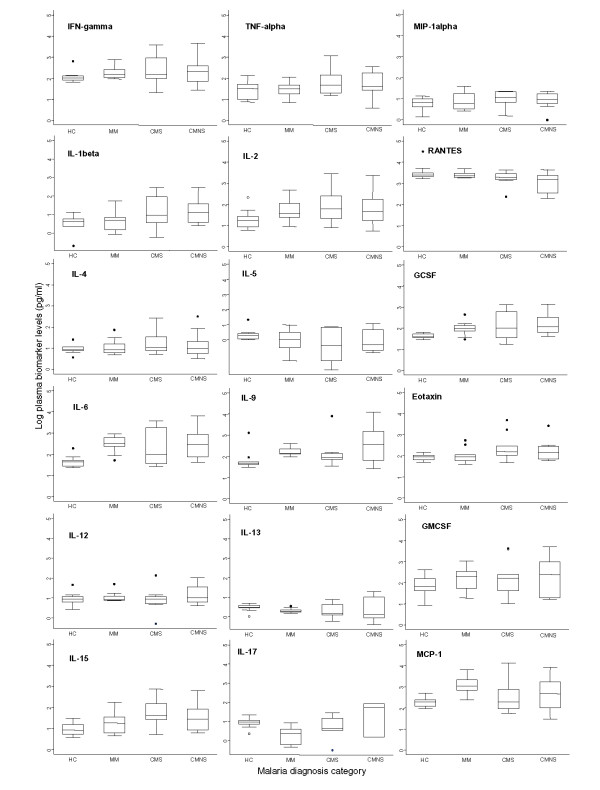
Log plasma biomarker levels and disease severity. Log median levels (pg/ml) of eighteen (18) biomarkers [IFN-γ, TNF-α, MIP-1α, IL-1β, IL-2, RANTES, IL-4, IL-5, G-CSF, IL-6, IL-9, Eotaxin, IL-12 (p70), IL-13, GM-CSF, IL-15, IL-17 and MCP-1 (MCAF)]. Biomarkers were quantified via Luminex™ from blood samples collected from patients at time of admission. HC – healthy controls, MM – mild malaria, CMS – cerebral malaria survivors, CMNS – cerebral malaria non-survivors. Box plots represent medians and 25th and 75th percentiles. Bars mark the 10th and 90th percentiles, and outliers are plotted as points. HC versus MM, CMS, and CMNS: *** p < 0.05, $$$ p < 0.0045 bonferroni adjustment (alpha = 0.05/18)